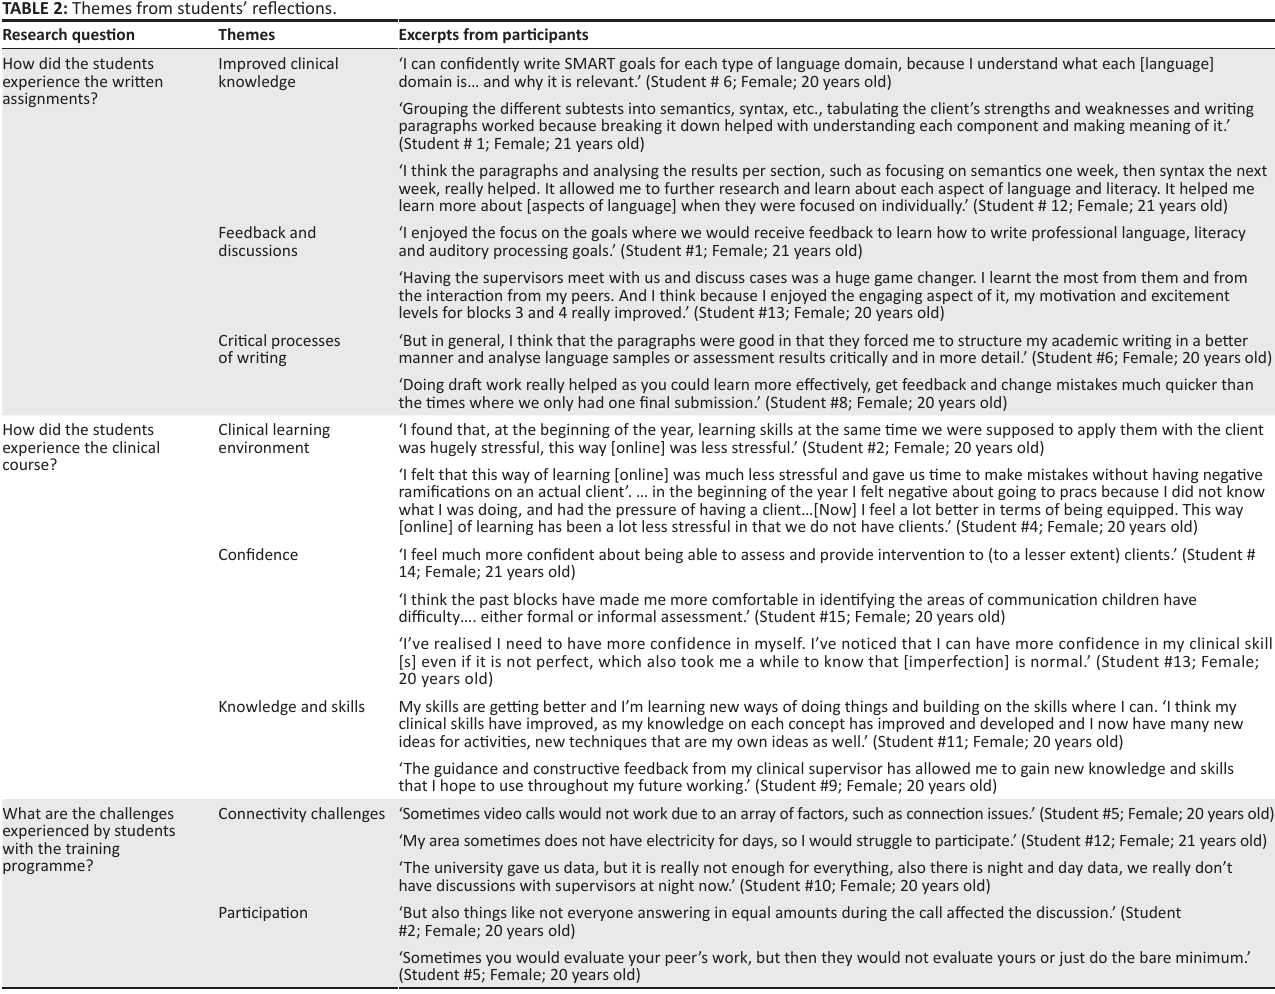
TABLE 2: Themes from students’